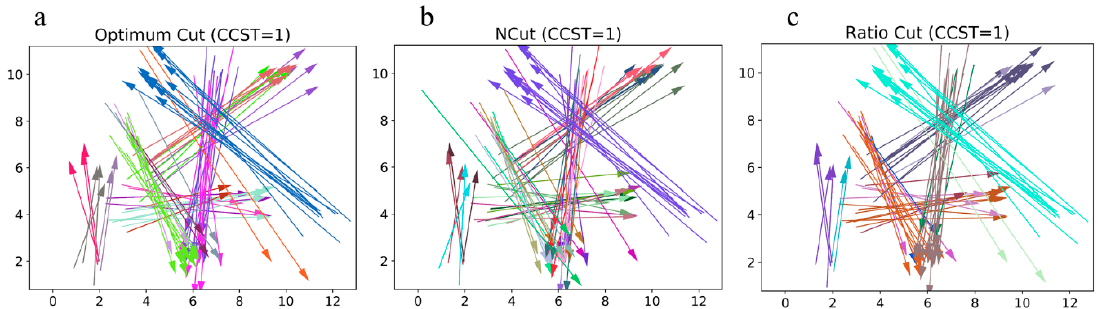
Figure 7. Clusters discovered by different spectral clustering methods: (a) Clusters discovered by optimum cut; (b) Clusters discovered by NCut; (c) Clusters discovered by Ratio cut;